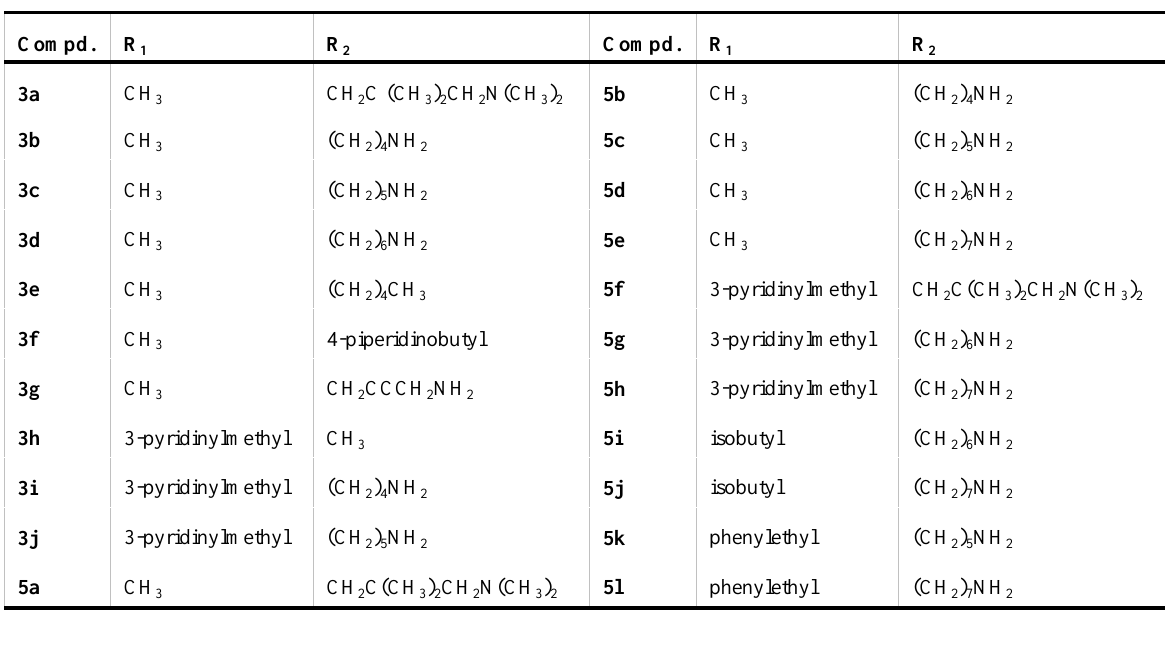
Table 1 . Formulae of compounds 3a-i and 5a-j